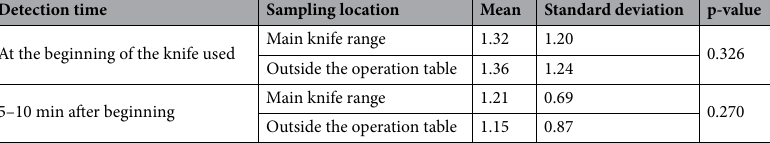
Table 5. The analysis of the concentration number of VOC and formaldehyde detected at different